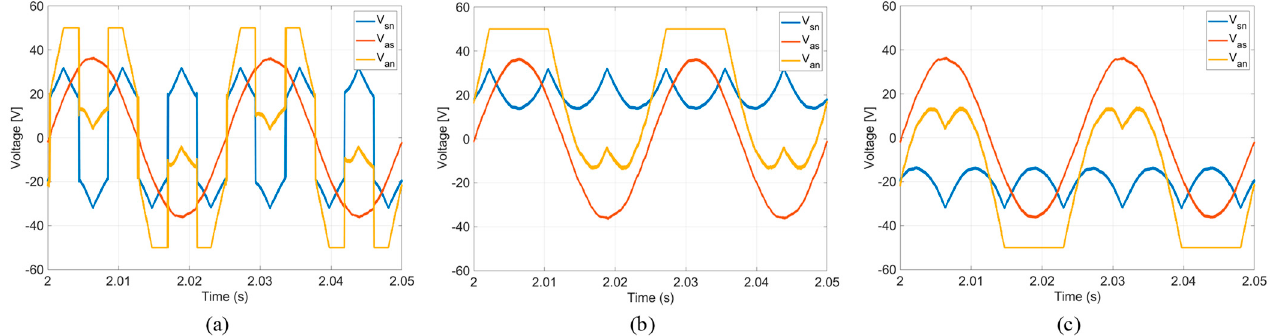
9 of 20 Figure 9. Voltage relationships of the 60° DPWM: ( a ) 60° (+30°) DPWM;( b ) 60° ( − 30°) DPWM. 3.4. Other Discontinuous Pulse-Width Modulations The 30° DPWM in Figure 4a has a complementary relationship with the 60° DPWM. Therefore, the offset voltage can be written as follows: 𝑉 (cid:3046)(cid:3041) (cid:3404) (cid:3398) 𝑉 (cid:3031)(cid:3030) 2 (cid:3398) 𝑉 (cid:3040)(cid:3036)(cid:3041)∗ (cid:4666)𝑤ℎ𝑒𝑛 𝑉 (cid:3040)(cid:3028)(cid:3051)∗ (cid:3397) 𝑉 (cid:3040)(cid:3036)(cid:3041)∗ (cid:3410) 0(cid:4667)